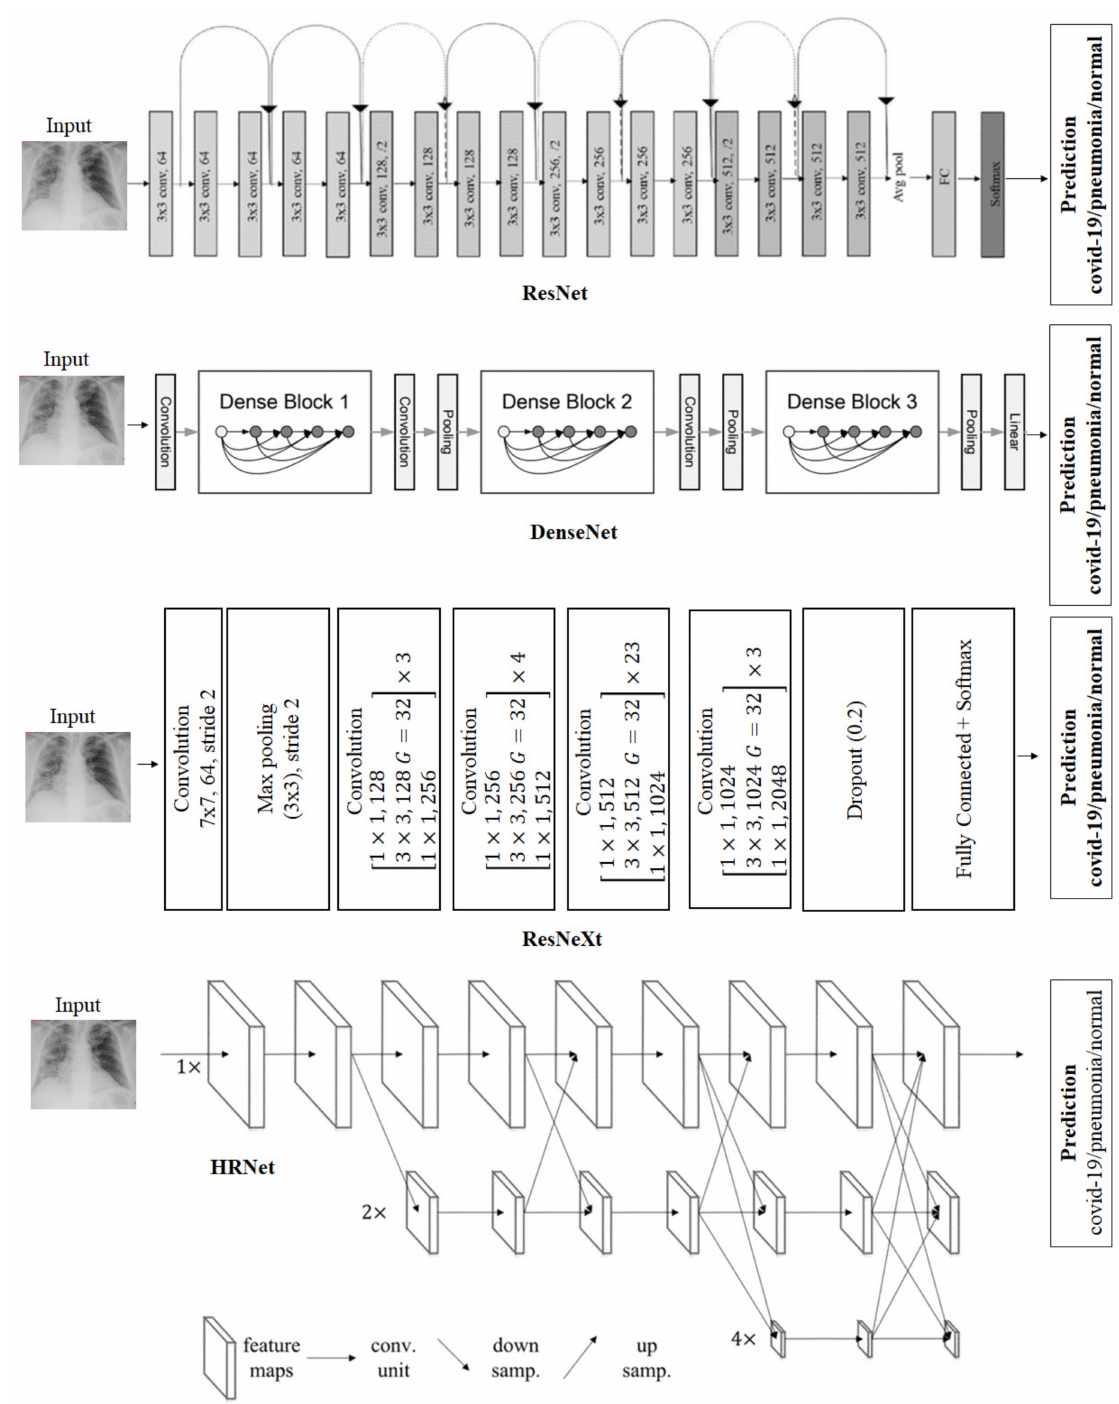
Figure 1. Architecture of deep learning models referred to as individual doctors utilized in our framework. From top to bottom: ResNet, DenseNet, ResNeXt, and